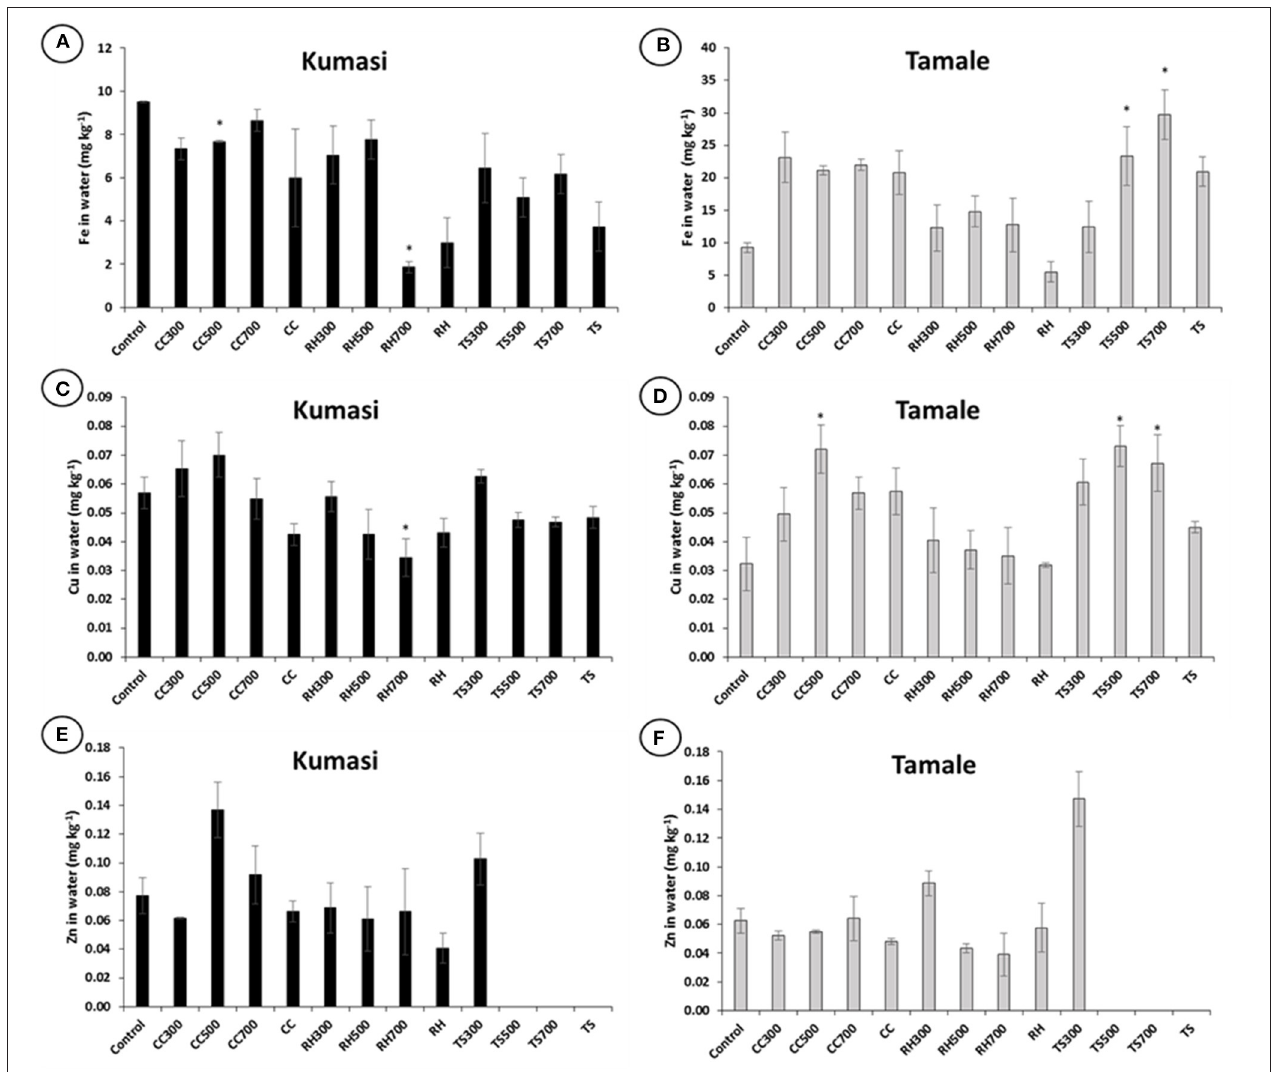
FIGURE 2 | Biochar influence on Fe, Cu, and Zn concentrations in water extracts in Kumasi (A,C,E) and Tamale (B,D,F) soil. The control treatment comprised no amendment. CC, RH and TS represent treatments amended with 5% (w/w) corn cob biochar, rice husk biochar, and teak sawdust biochar, respectively made in the laboratory at 300, 500, or 700 ◦ C, or made in the field using an ELSA barrel (CC) or a Japanese retort stove (RH and TS). Some measurements Zn concentrations in water extracts of teak sawdust biochar amended soils were below detection limit (0.08mg kg − 1 ). Data with asterisks are statistically significantly different from control ( p < 0.05). Error bars represent standard deviation n =